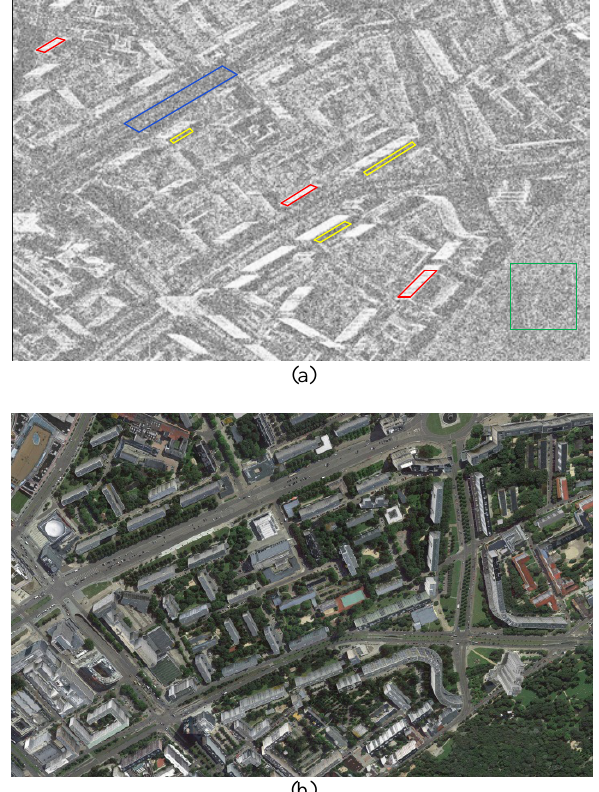
Figure 1. The coverage of the data. (a) The coherence image of the data. (b) The corresponding area in Google Earth. For comparing convenience, symmetry along the vertical direction is utilized.